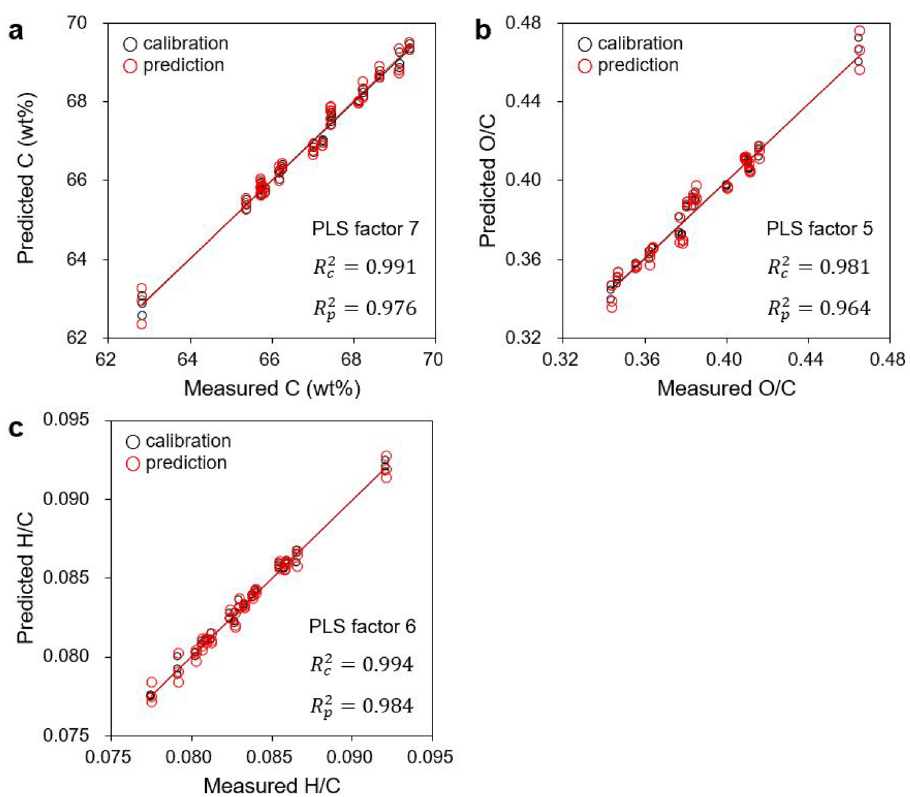
Figure 4. Scatter plots of prediction results for carbon content ( a ), O/C ( b ), and H/C ( c ) by PLSR models trained with second-derivative NIR spectra. R 2 c coefficient of determination for calibration, R 2 p coefficient of determination for